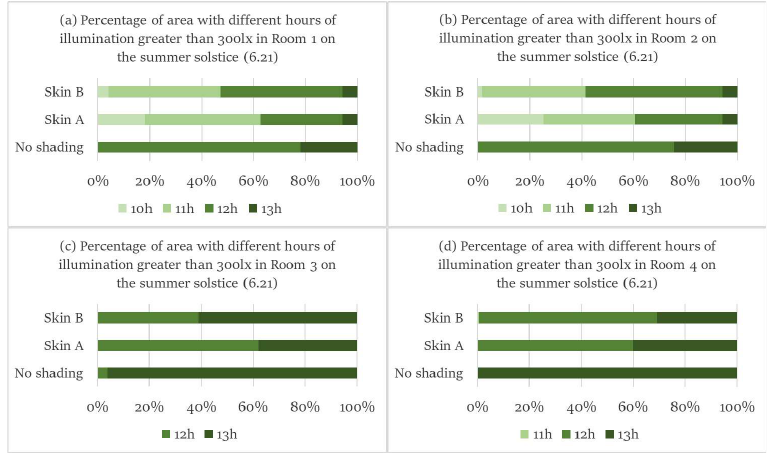
Figure 15. Percentage of area with different hours of illumination greater than 300l× in ( a ) Room 1, ( b ) Room 2, ( c ) Room 3, and ( d ) Room 4 on the summer solstice (6.21) (self-developed).